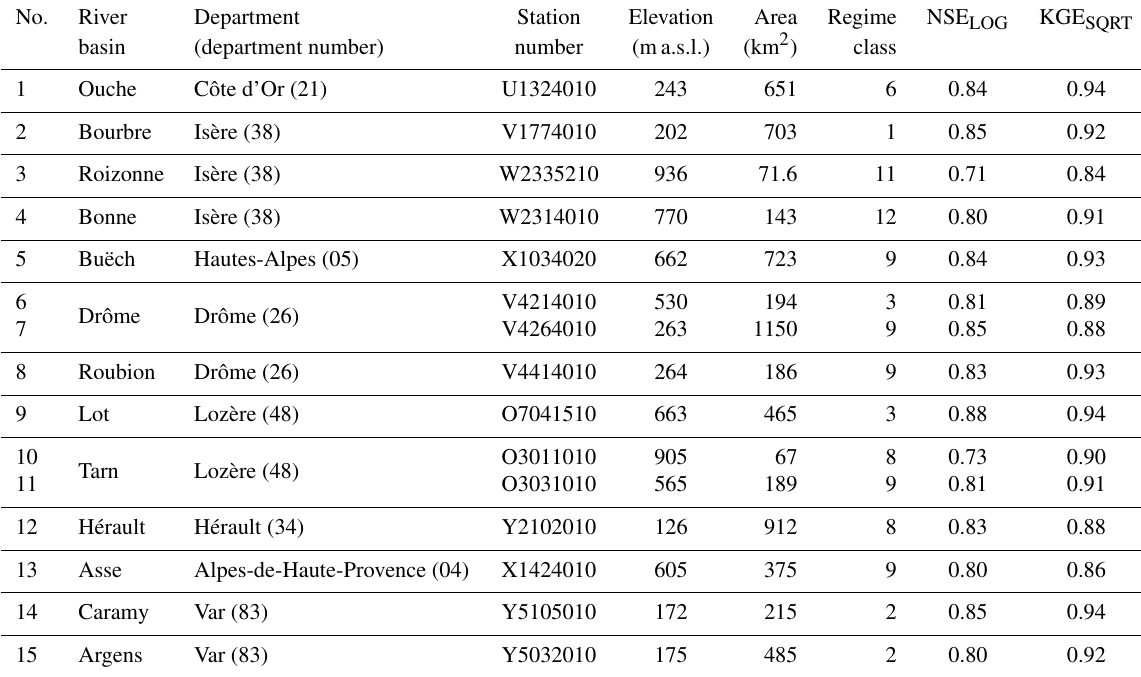
Table 1. Main characteristics of the 15 catchments used for validation of water-restriction simulations. Station number refers to the catchment number in the HYDRO database, and regime class refers to the classification suggested by Sauquet et al. (2008) with a gradient from Class 1 – pluvial-fed regime –F moderately contrasting with Class 12 – snowmelt-fed regime. No.